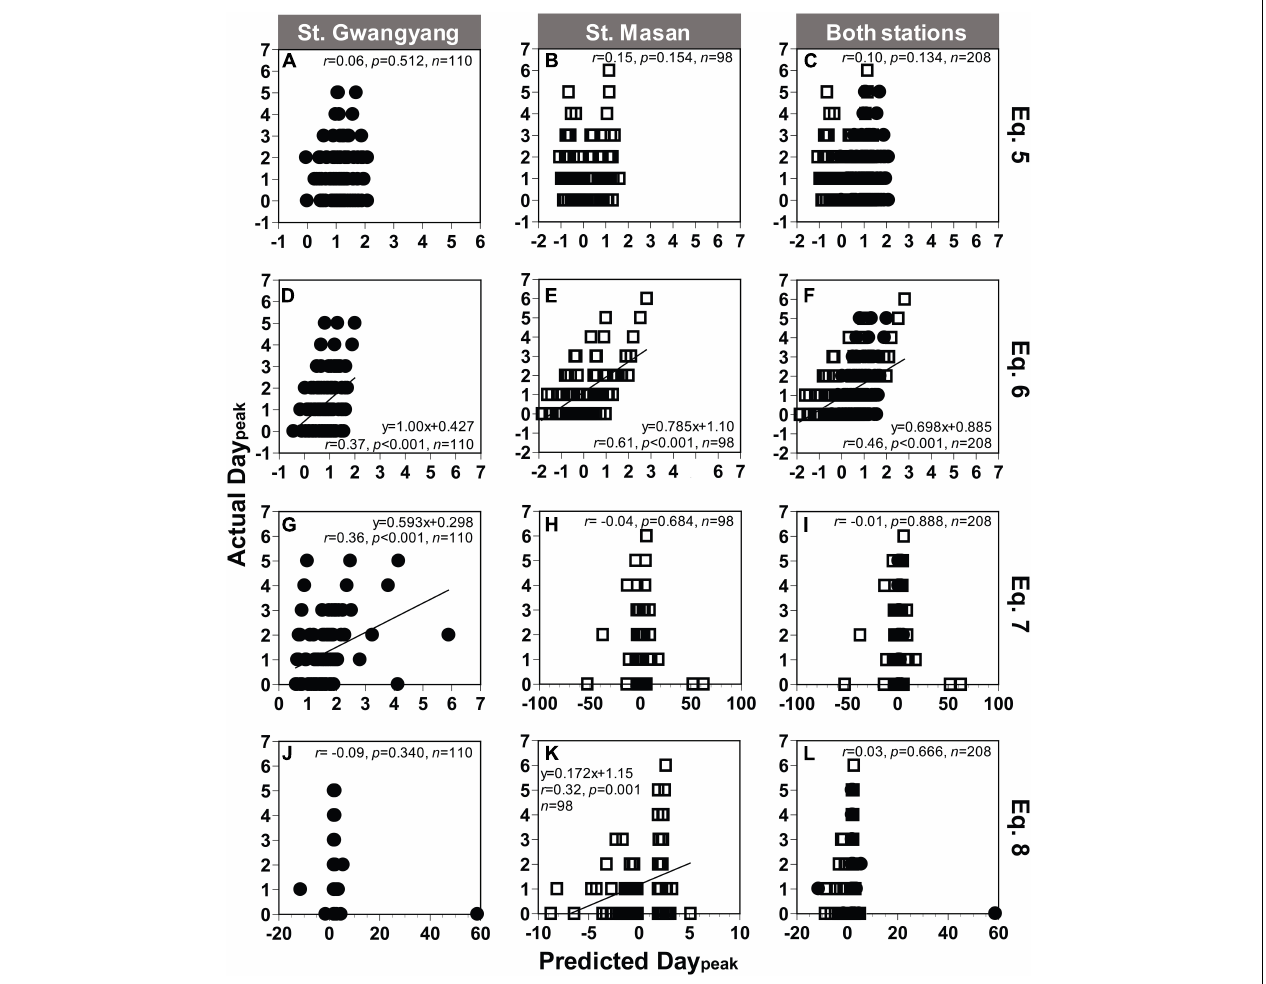
FIGURE 9 | Comparison between the actual and predicted values of the day elapsed until the Chl- a peak occurred (Day peak ) at St. Gwangyang (closed circle), St. Masan (open square), and both stations. The predicted Day peak values calculated using concentrations of NO 3 and Chl- a at each station and Eq. 5 (A–C) , Eq. 6 (D–F) , Eq. 7 (G–I) , and Eq. 8 (J–L) in Table 2 . Predicted Day peak in panels ( G–L) were calculated using the predicted Chl- a peak from Eq.